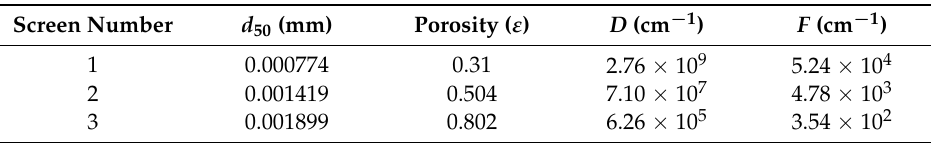
Table 1. Porosity of different